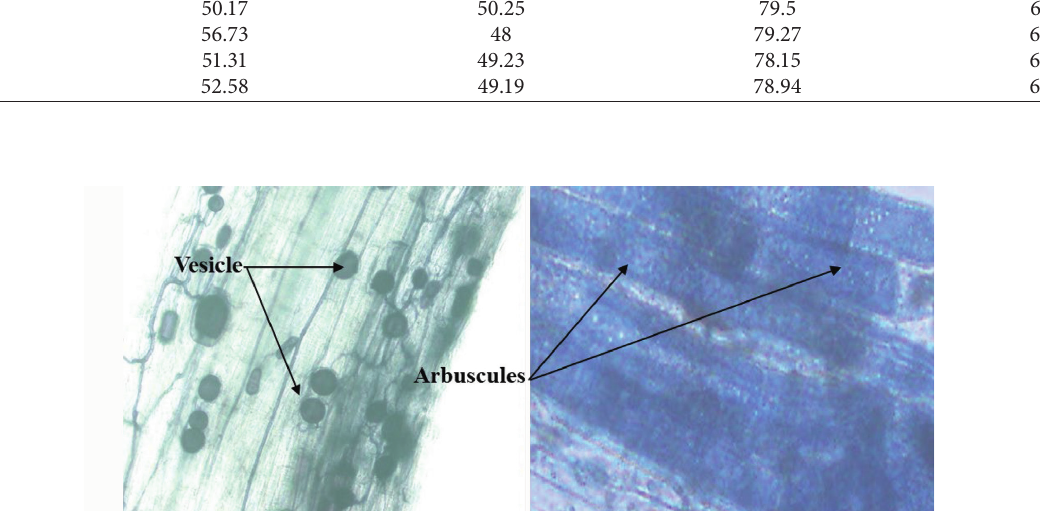
Table 2: The mean spore count in varying depths from different sampling sites before and after bulking. Mean no. of spores before bulking Sampling area